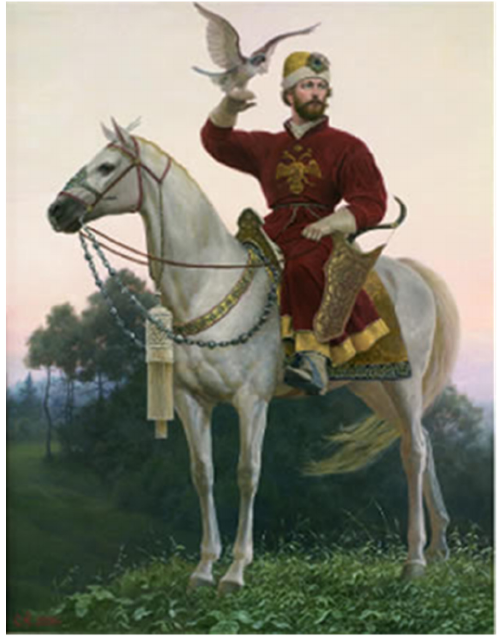
Figure 15. A Falcon Hunter.